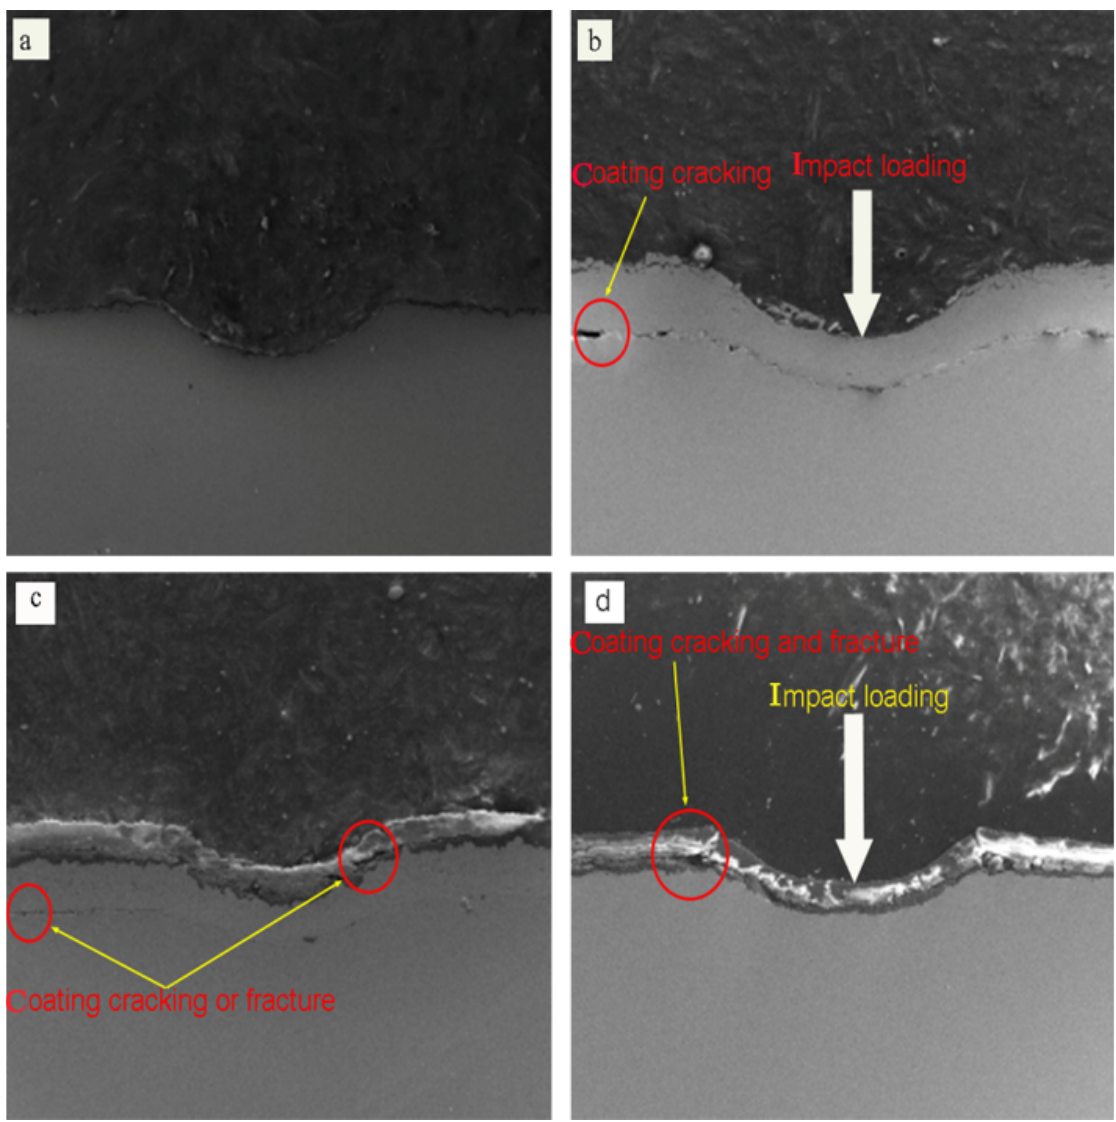
Figure 6: Micrograph of indentation section: (a)Substrate; (b)NiCr coating; (c)Al 2 O 3 coating with the undercoating of NiCr; (d)Al 2 O 3 coating